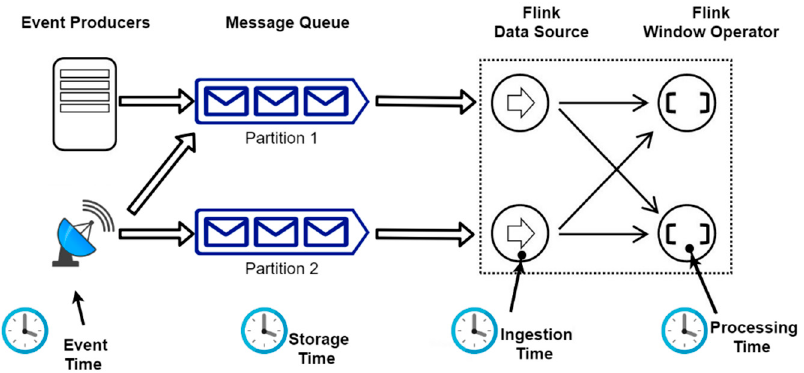
Figure 7. Different notions of time in a stream processing lifetime.